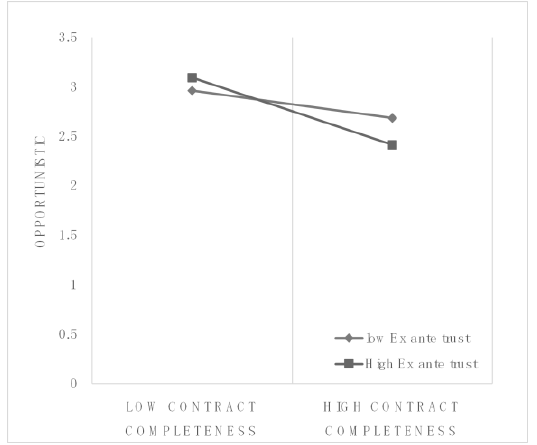
Figure 3. Interaction effect of EAT and CC.